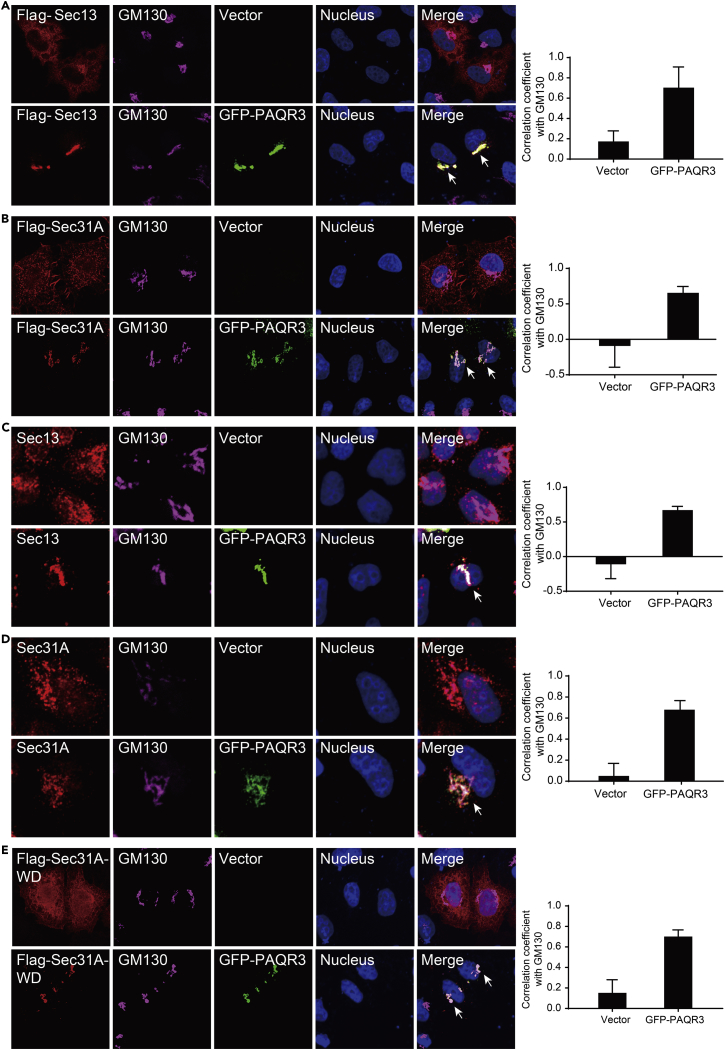
PAQR3 Tethers Sec13 and Sec31A to the Golgi Apparatus(A and B) Subcellular localization of exogenous Sec13 and Sec31A in the absence or presence of overexpressed PAQR3. HeLa cells were transiently transfected with FLAG-tagged Sec13, FLAG-tagged Sec31A, and GFP-fused PAQR3 as indicated. The transfected cells were fixed and then stained with an anti-FLAG antibody to detect Sec13/Sec31A. The Golgi was stained with an antibody against GM130, and the nucleus was stained with Hoechst 33342. The arrow indicates apparent co-localization of exogenous Sec13 and Sec31A with PAQR3.(C and D) Subcellular localization of endogenous Sec13 and Sec31A with or without the presence of PAQR3. HeLa cells were transfected with GFP-fused PAQR3 alone. The transfected cells were fixed and then stained with antibodies against Sec13 and Sec31A. The arrow indicates apparent co-localization of endogenous Sec13 and Sec31A with PAQR3.(E) Subcellular localization of the WD domain of Sec31A. HeLa cells were transiently co-transfected with FLAG-tagged WD domain of Sec31A (Sec31A-WD) and GFP-fused PAQR3. The transfected cells were fixed and then stained with an anti-FLAG antibody. The arrow indicates apparent co-localization of the WD domain of Sec31A with PAQR3. Quantitation of the co-localization of the proteins is shown in the right panel (n > 6).